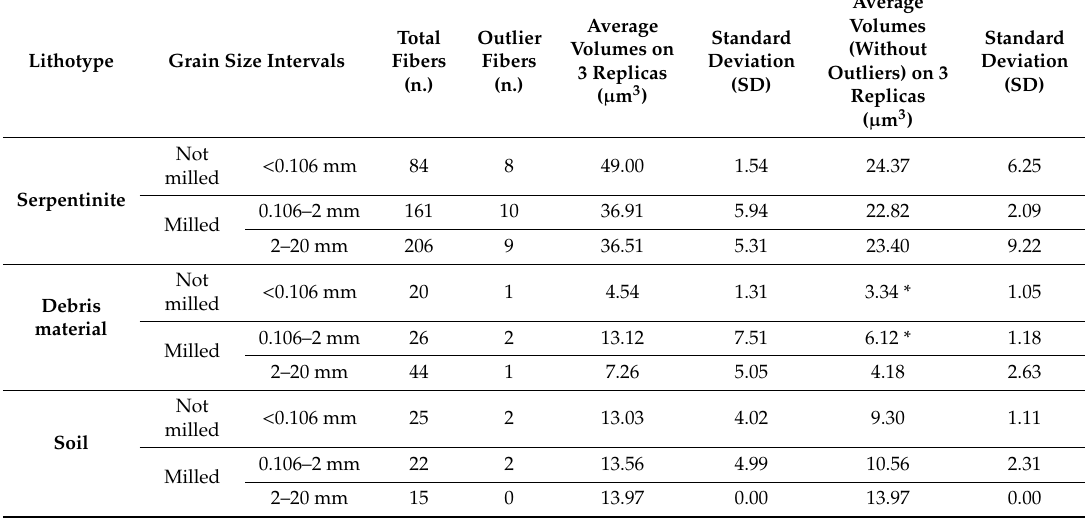
Table 2. Average volumes of the three replicates (R1, R2, R3) for each particle size fraction. Average volume was calculated considering (first column) and not considering the outliers (second column). The total number of fibers and the total number of fibers excluding the outliers are also